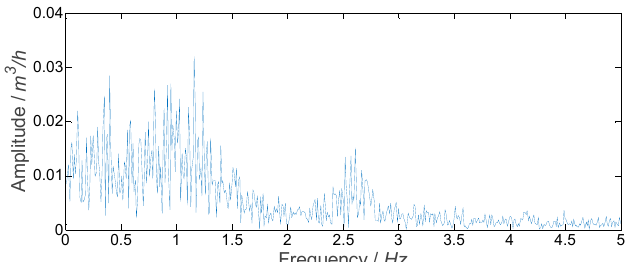
Figure 10. Frequency spectrum of measured result for experiment No. 1.